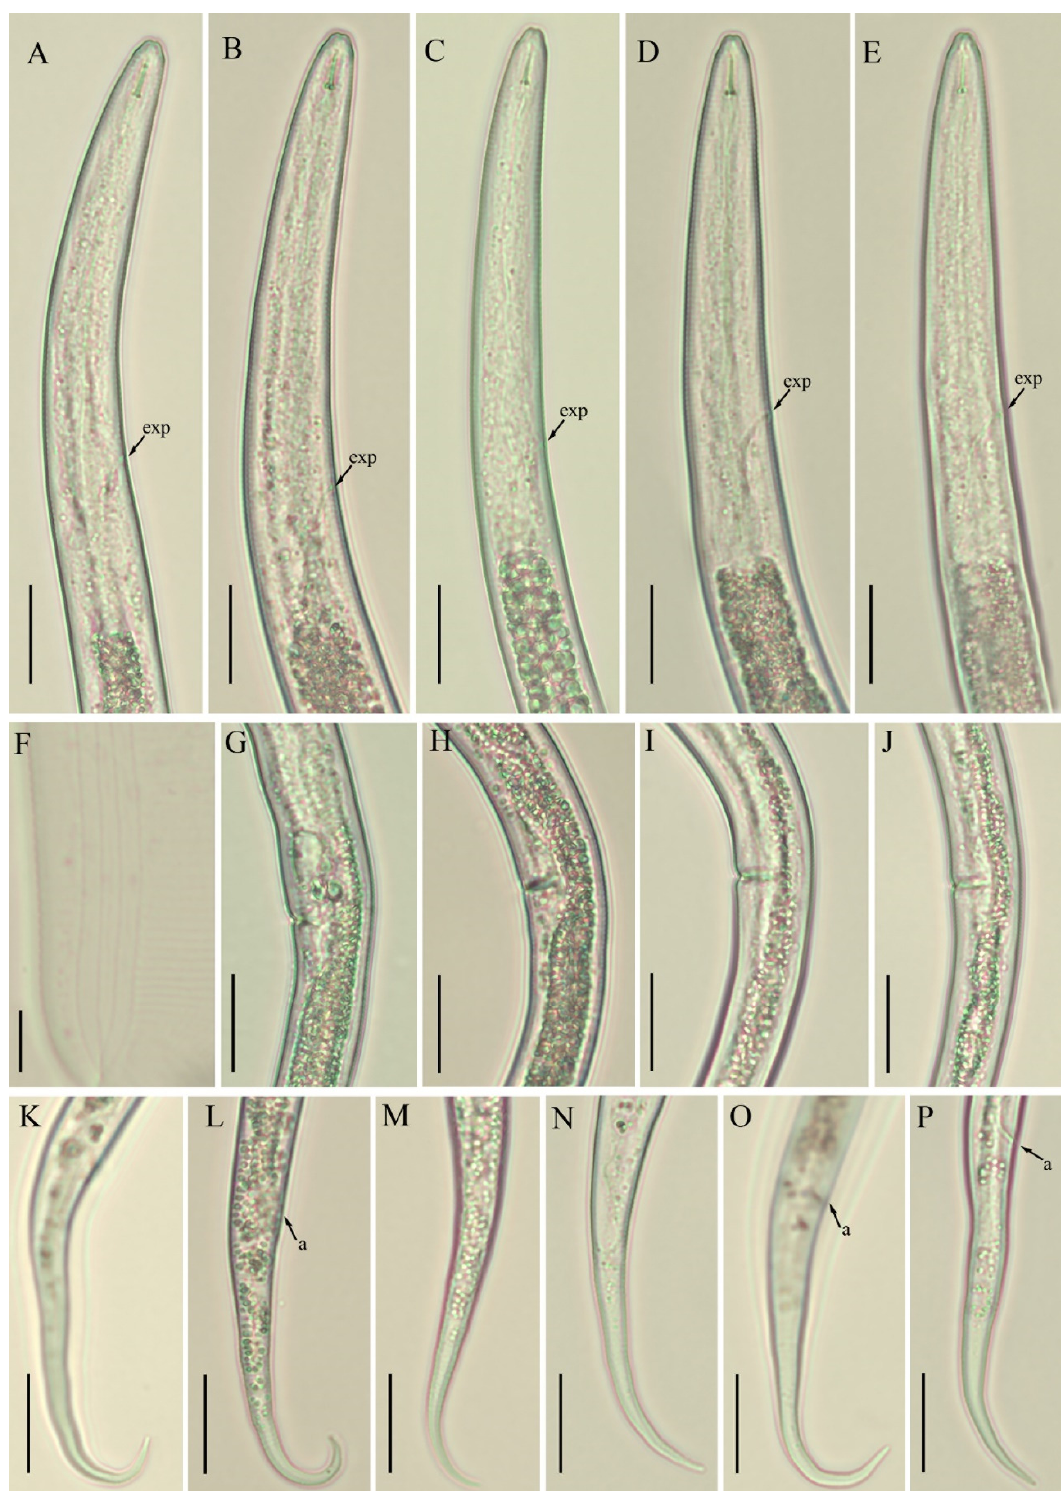
Figure 3. Photomicrographs of Boleodorus thylactus female, Canadian populations 40, 50, and 62. ( A – B ; C ; D , E ) pharyngeal region of population 40; 50; and 62, respectively; ( F ) lateral lines; ( G ; H , I ; J ) vulval regions of populations 40; 50; and 62, respectively; ( K , L ; M , N ; O , P ) tail regions of populations 40; 50; and 62, respectively. Scale bars: ( A – E, G – P ) 20 µm; ( F ) 5 µm. Arrowheads: (a) anus; (exp) excretory pore.